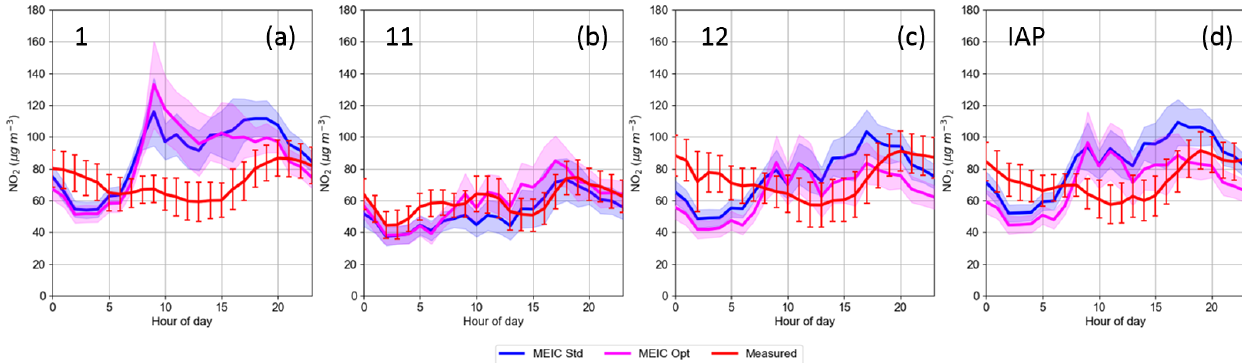
Figure 10. Campaign period mean diurnal variation in modelled and measured NO 2 concentrations at sites (a) 1, (b) 11, (c) 12, and (d) IAP. Modelled concentrations produced using both MEIC Std (blue) and MEIC Opt (pink). Measurements marked by red line. Shaded areas and error bars represent the 95% confidence intervals for simulated and measured concentrations,